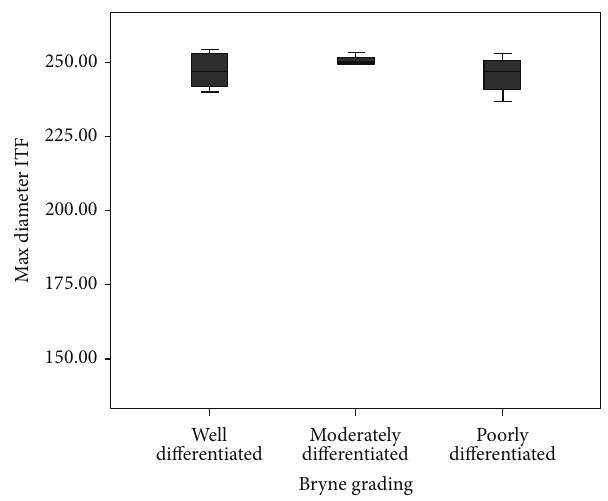
Figure 4: This graph depicts the relation of maximum diameter at invasive front with Bryne et al. grading in oral squamous cell carcinoma patients (graph depicted “maximum diameter invasive tumour front as Max diameter ITF”) ( 𝑛 = 32 ). The statistical significance was calculated using Chi-square test and compared.